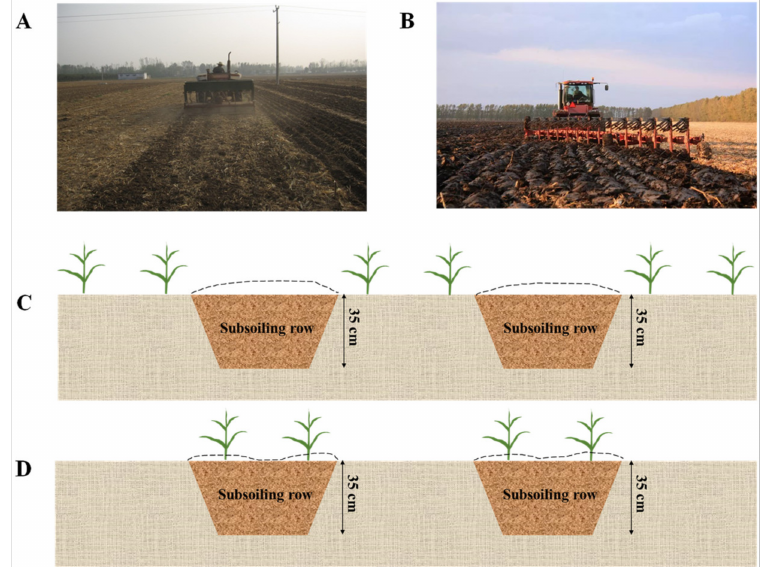
Figure 10. Scheme representative of the tillage management: ( A ) rotary tillage in wheat season, ( B ) deep tillage in wheat season, ( C ) inter-row deep tillage in maize season, and ( D ) intra-row deep tillage in maize